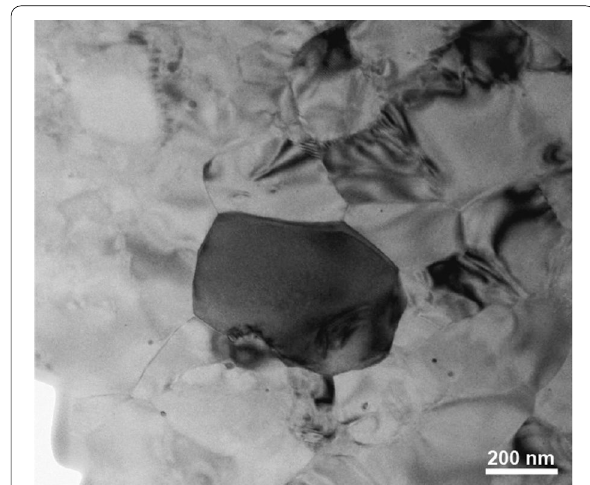
Fig. 6 BF-TEM images of dissociated olivine in the shergottite DaG 735. a Granular bridgmanite bridgmanite magnesiowüstite. Most bridgmanite have been vitrified. Bdg: bridgmanite, Mw: magnesiowüstite +